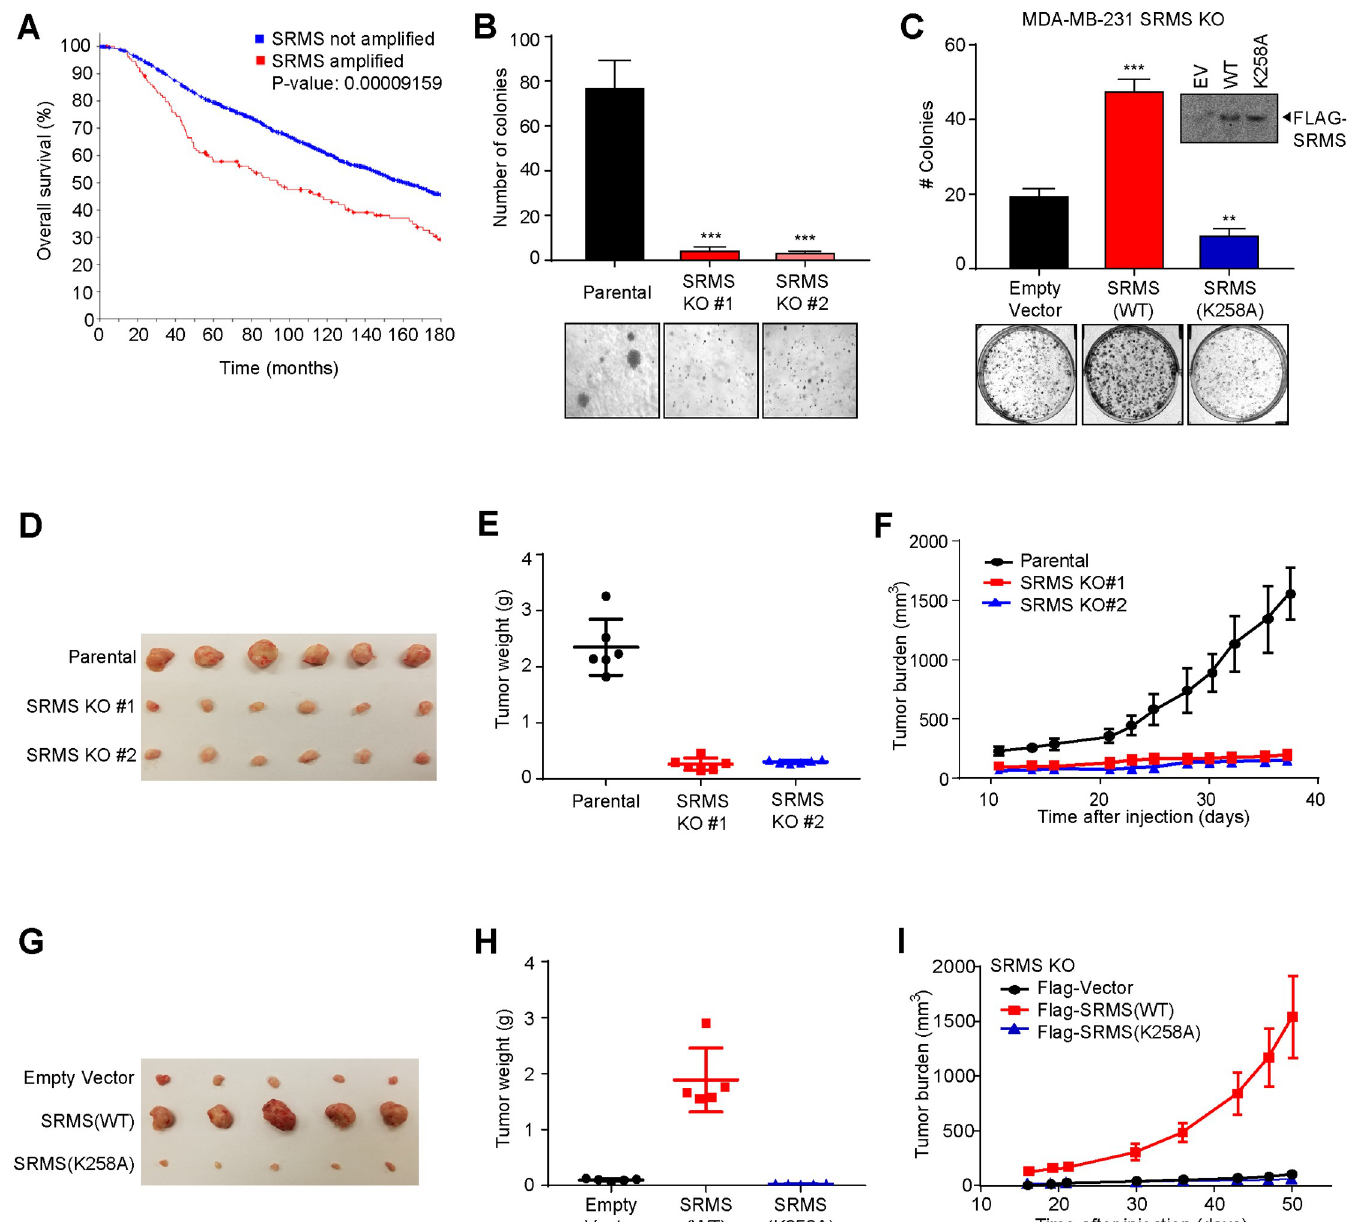
Fig 6. SRMS promotes tumor growth in a kinase-dependent manner. ( A ) SRMS amplification correlates with poor overall survival in breast cancer patients. The METABRIC cohort of 2,173 breast cancer patients were split into SRMS-nonamplified (blue) and SRMS-amplified (red) groups. Overall, survival of each group was plotted. ( B ) SRMS is required for anchorage-independent growth of MDA-MB-231 triple-negative breast cancer cells. Parental or SRMS KO MDA-MB-231 cells were seeded sparsely in soft agar and allowed to grow for 23 days. Mean + standard deviation for n = 3 replicates are shown along with representative images. ��� p < 0.001. ( C ) SRMS kinase activity supports clonogenic growth of MDA-MB-231 cells. SRMS KO MDA-MB-231 cells were transfected with empty vector, SRMS WT, or SRMS K258A kinase-dead mutant and plated sparsely. After 20 days of clonogenic growth, colonies were stained with crystal violet, imaged, and counted. Mean + standard deviation of n = 3 replicates is shown along with representative images. �� p < 0.01, ��� p < 0.001, t test. (Relates to S6D Fig). ( D–F ) Xenograft tumor growth was compared between parental vs. SRMS KO MDA-MB-231 cells injected subcutaneously into Nod-Scid gamma mice. Relative tumor burden ( D ) and tumor weights ( E ) corresponding with the endpoint of the growth curve ( F ) are shown. Mean +/ − standard deviation of n = 6 mice per condition. ( G–I ) SRMS KO MDA-MB-231 cells were reconstituted with the indicated constructs and injected subcutaneously into Nod-Scid gamma mice. Relative tumor burden ( G ) and tumor weights ( H ) corresponding with the endpoint of the growth curve ( I ) are shown. Mean +/ − standard deviation of n = 5 mice per condition. The data underlying the figure can be found in S1 Data. EV, empty vector; KO, knockout; SRMS, Src-related kinase lacking C-terminal regulatory tyrosine and N-terminal myristylation sites; WT. wild-type.